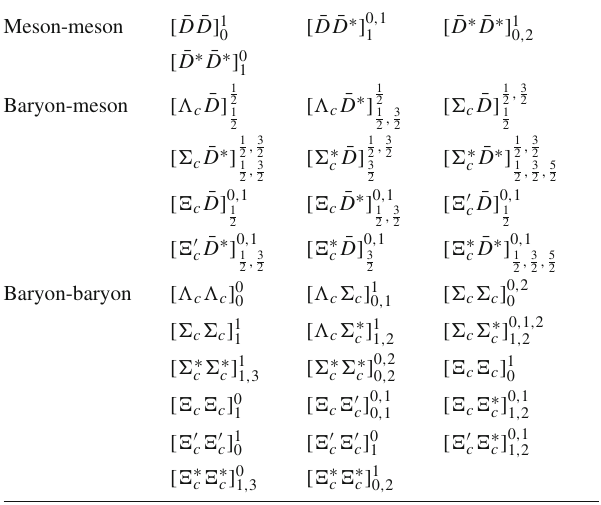
Table 1 The allowed heavy flavor di-hadron systems ( [ H 1 H 2 ] I are considered in this work, where the quantum numbers of the general identical systems are constrained by Eq.